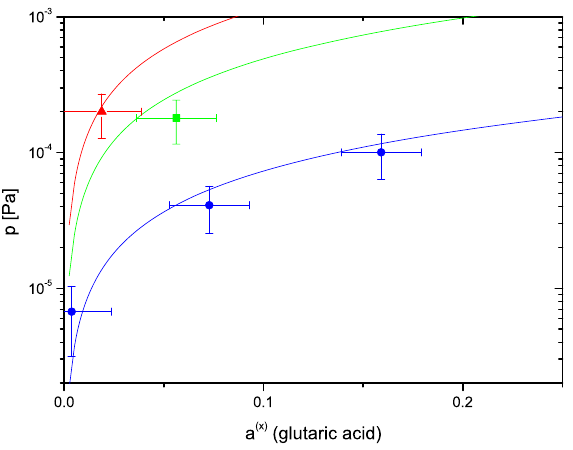
Fig. 12. Oxalic acid vapor pressure versus temperature. Our mea- surements for the solid, (supercooled) liquid, and saturated solution states are plotted as indicated in the key. For comparison a selection of literature data is plotted as well, together with extrapolations to ambient temperature.